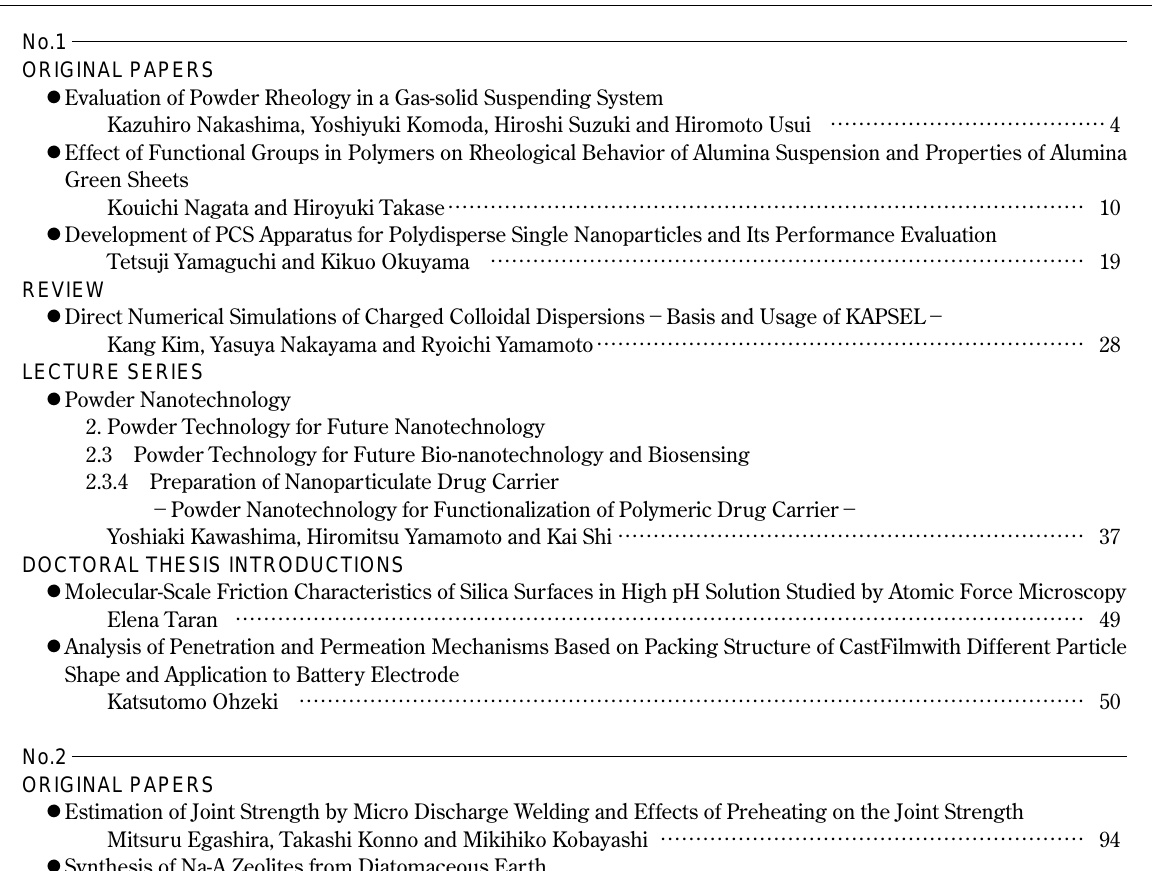
・ Estimation of Joint Strength by Micro Discharge Welding and Effects of Preheating on the Joint Strength Mitsuru Egashira, Takashi Konno and Mikihiko Kobayashi …………………………………………………… 94 ・ Synthesis of Na-A Zeolites from Diatomaceous Earth Hidekazu Tanaka, Yoshiki Tanaka, Hirishi Kira and Ryozi Hino ……………………………………………… 101 ・ Effect of Flow Behavior in De-NOx Catalyst Honeycomb on Adhesion of Particles to the Wall Ryoichi Kurose, Takanobu Michioka, Hisao Makino and Satoru Komori ……………………………………… 107 ・ Recent Technology of Wet-type Particle